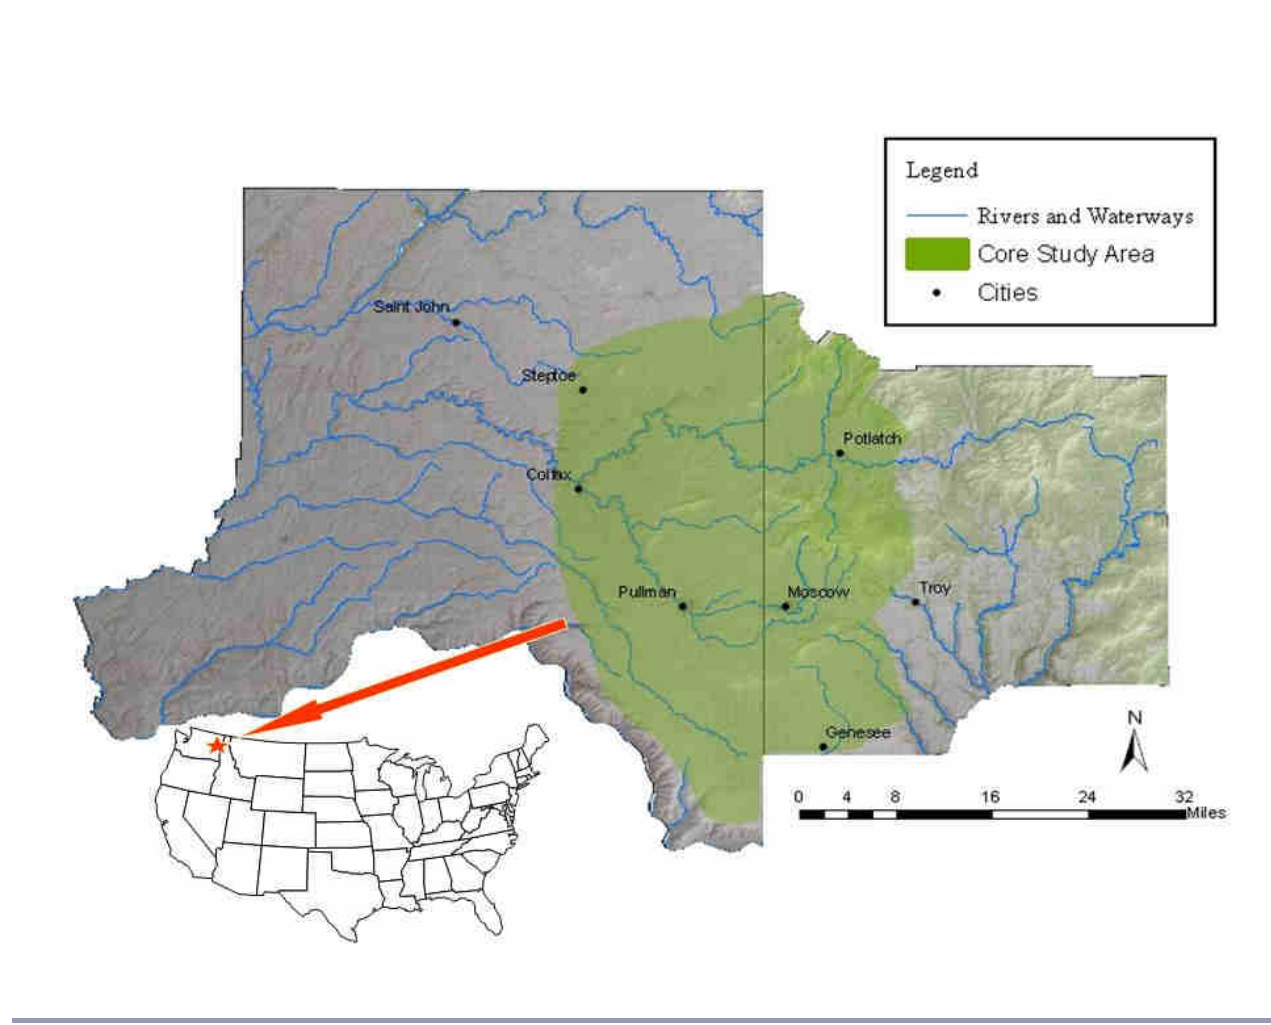
Fig. 1 . Core study area and participatory mapping base